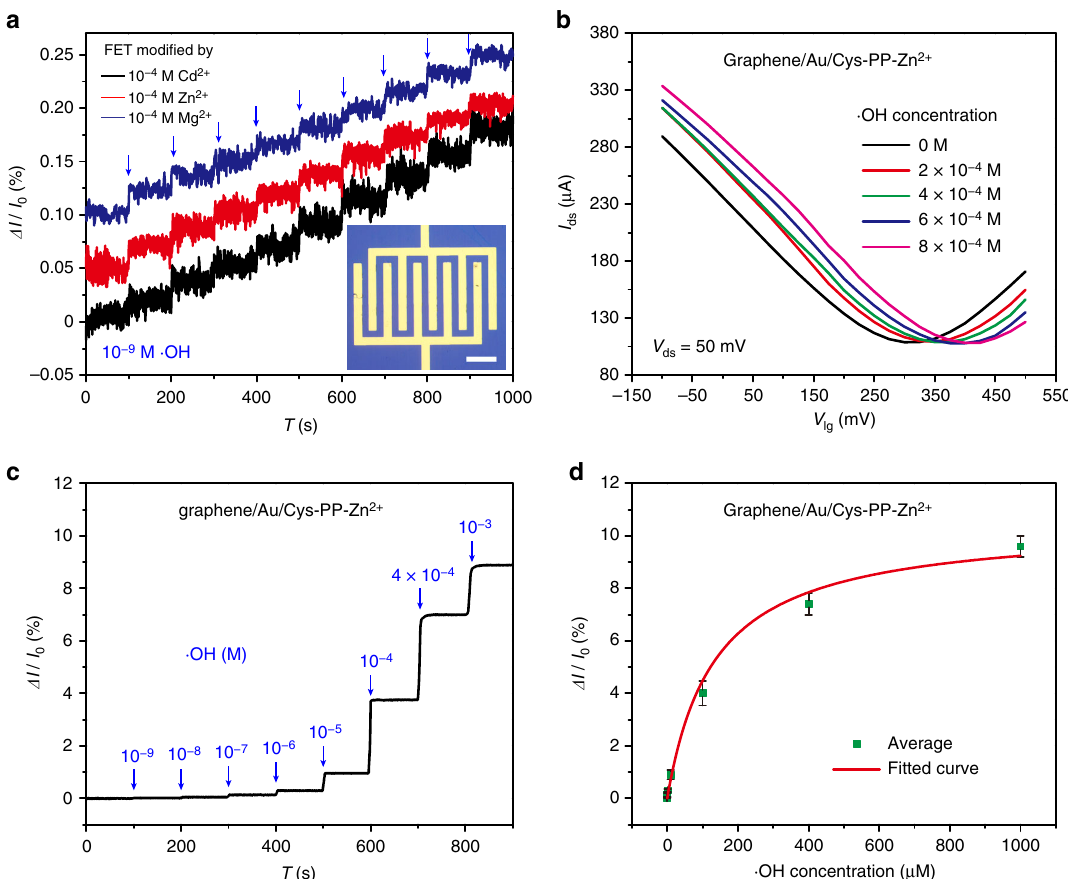
Fig. 3 The fi eld-effect transistor (FET) sensor with Cd 2 + , Zn 2 + , and Mg 2 + as the indicator. a Real-time electrical responses of a graphene/Au/Cys-PP- metal ion FET device (modi fi ed in 10 − 4 M Cd 2 + , Zn 2 + , or Mg 2 + ) upon successive addition of 10 − 9 M (cid:129) OH. The inset shows the FET device with interdigital electrodes. b Liquid gate transfer curves ( V ds = 50 mV) of a graphene/Au/Cys-PP-Zn 2 + FET device (modi fi ed in 10 − 4 M Zn 2 + ) before and after addition of 2 × 10 − 4 , 4 × 10 − 4 , 6 × 10 − 4 , and 8 × 10 − 4 M (cid:129) OH, when V lg varies from − 100 to 500 mV. c Real-time response upon various concentrations of (cid:129) OH (from 10 − 9 to 10 − 4 M) for the graphene/Au/Cys-PP-Zn 2 + FET device (modi fi ed in 10 − 4 M Zn 2 + ). d The electrical responses versus the (cid:129) OH concentration for the graphene/Au/Cys-PP-Zn 2 + FET device (modi fi ed in 10 − 4 M Zn 2 + ). The scale bar in a is 200 μ m. The error bars are de fi ned by the